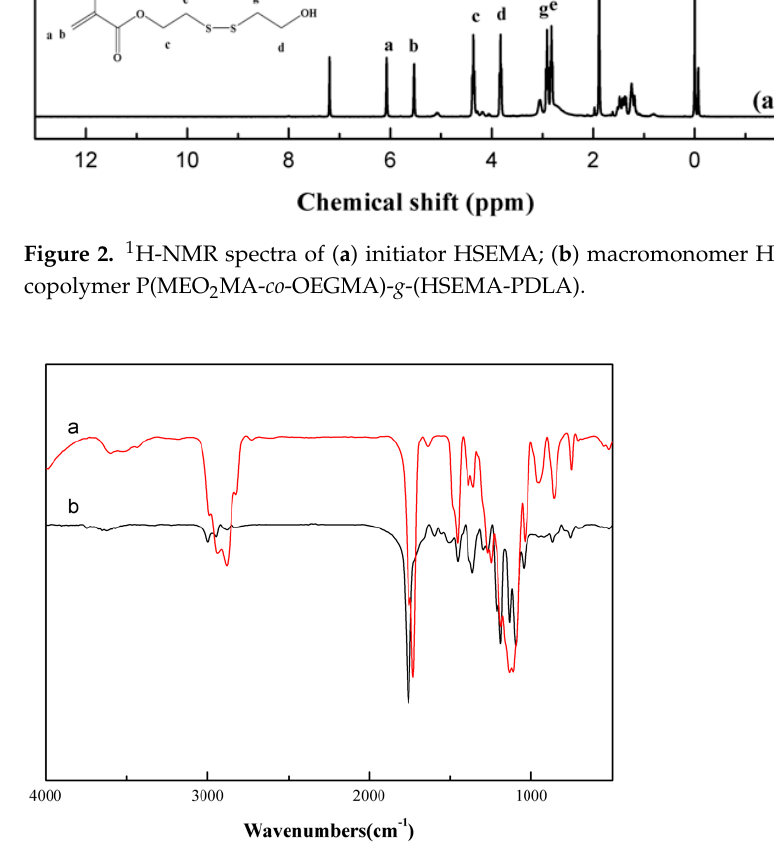
Figure 3. FTIR spectra of ( a ) gel4; ( b ) macromonomer HSEMA-PDLA.